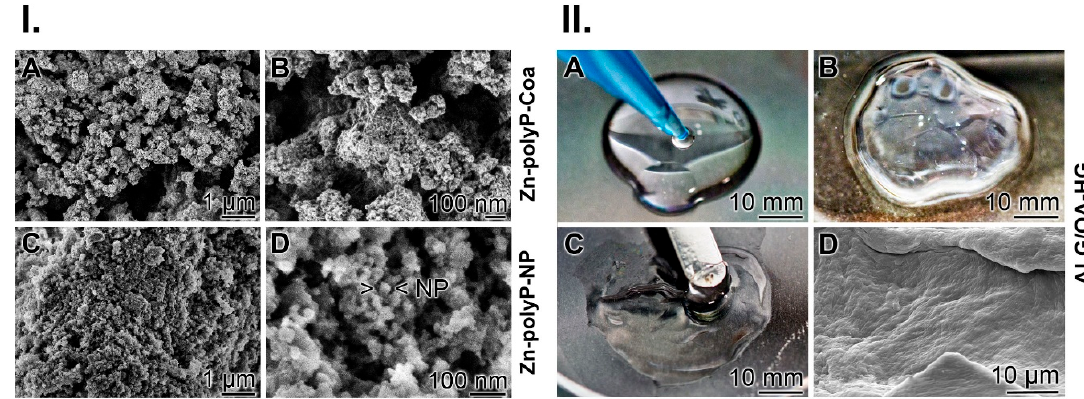
Figure 2. Formation of Zn-polyP coacervate and preparation of alginate-oxidized alginate hydrogel. ( I. ) Fabrication of Zn-polyP coacervate and Zn-polyP-NP; SEM. ( A , B ) Addition of ZnCl 2 at super-stoichiometric concentration ratio to Na-polyP at pH 7 results in the formation of the aqueous coacervate phase which, after drying, appears as jagged material. ( C , D ) If the reaction is run at pH 10 nanoparticles (NP) are formed. ( II. ) Preparation of the alginate-oxidized alginate hydrogel. ( A ) Alginate was added dropwise to oxidized alginate (OA-50). ( B ) After gel formation ( C ) gelatin was added, resulting in an increased viscosity of the hydrogel. ( D ) Finally, the material was ionically cross-linked with ZnCl 2 and freeze-dried;